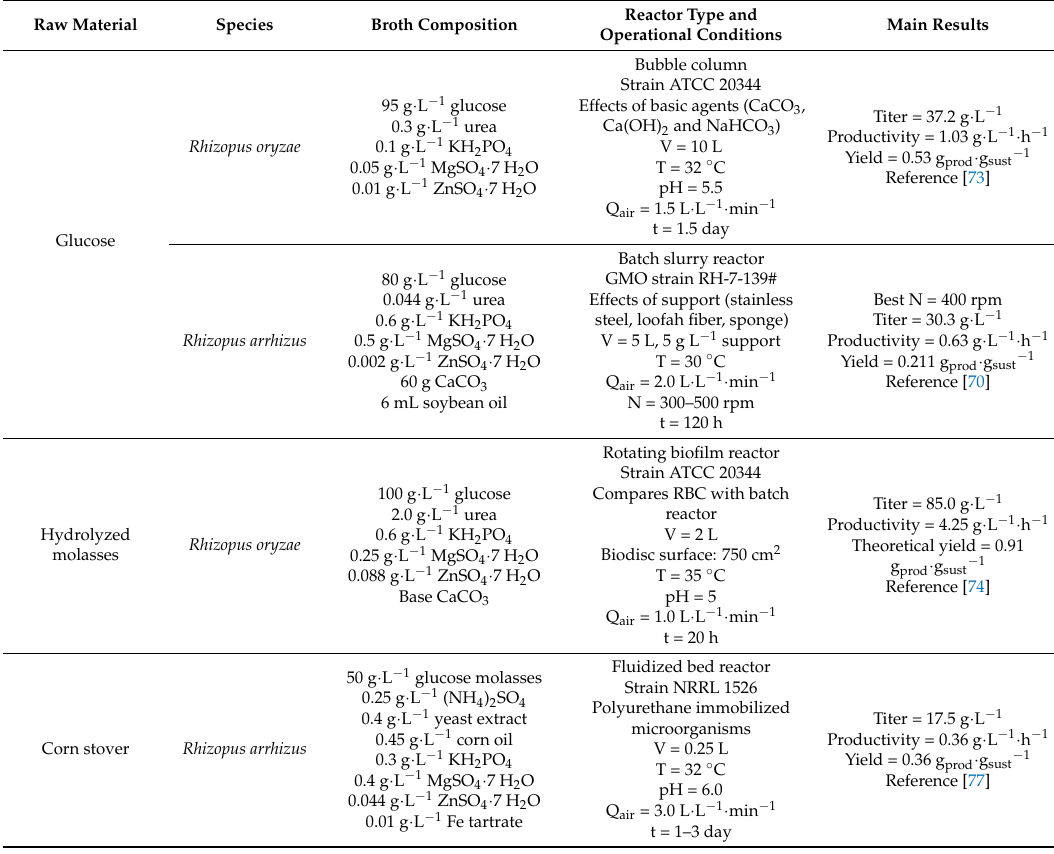
Table 3. Main results in batch special